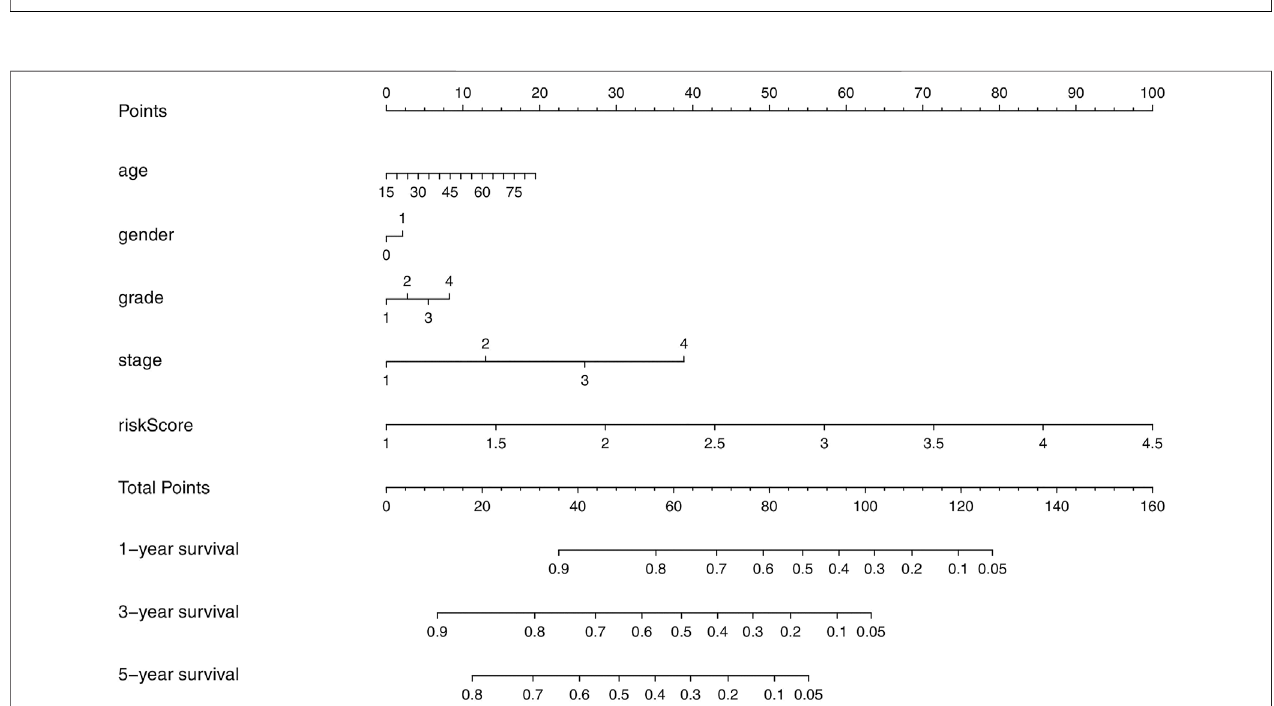
FIGURE 7 | Nomogram containing the risk score to predict the overall survival in the HCC patients.